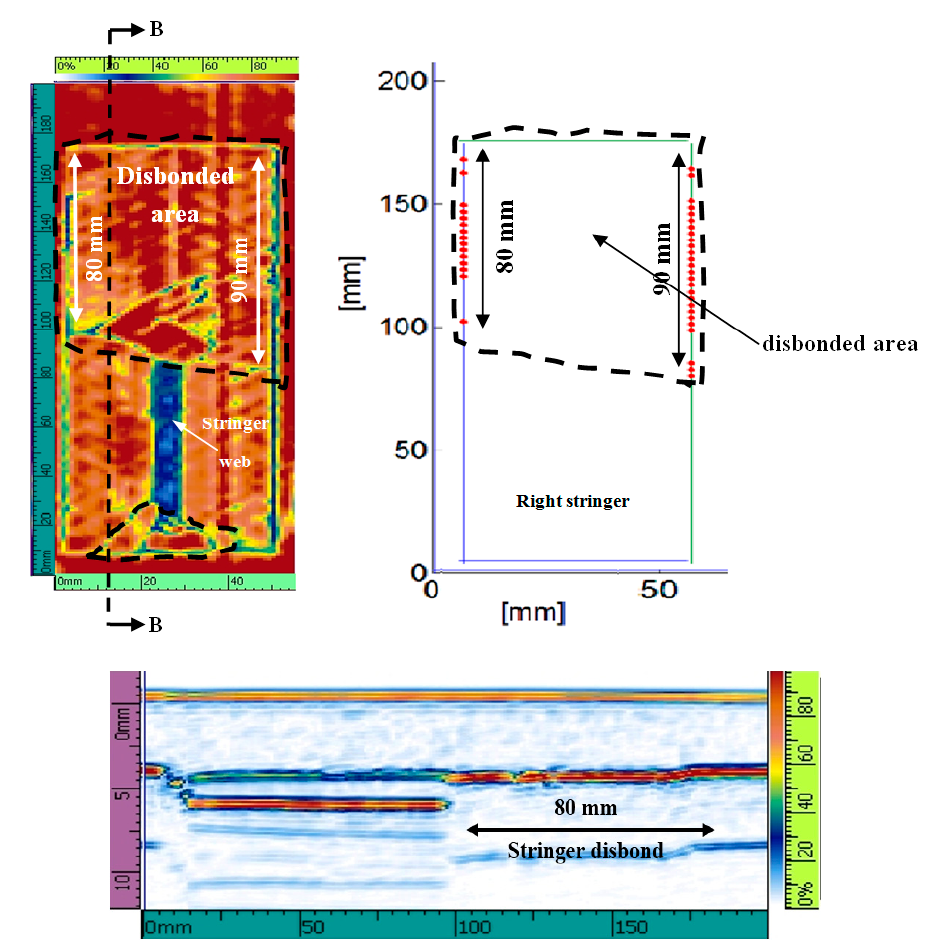
Figure 11. Panel PNL1: left stringers C-scan ( upper ) and B–B longitudinal section with B-scan view ( bottom )—scan length 200 mm.